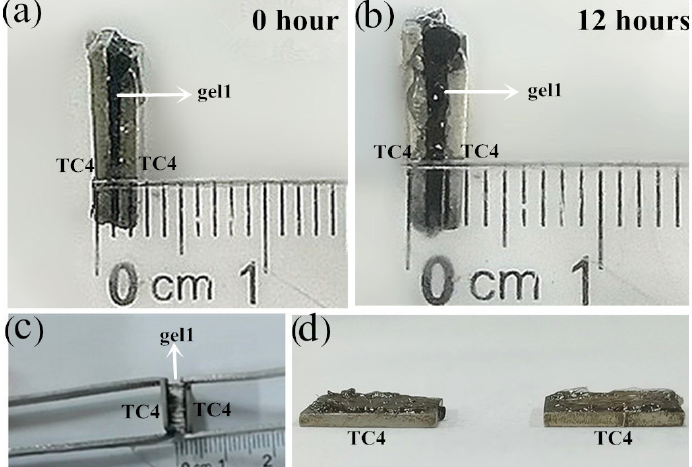
Figure 4. ( a ) The picture of gel1 formed between two pieces of TC4, ( b ) the picture of gel1 soaked between two pieces of TC4, ( c ) the picture of two pieces of TC4 stretched, ( d ) the picture of two pieces of TC4 pulled apart. of TC4 pulled